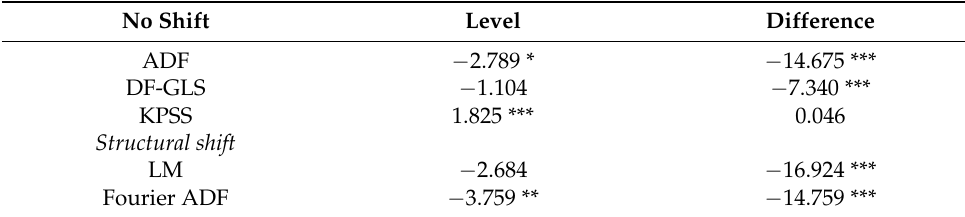
Table 1. Results from unit root tests for oil